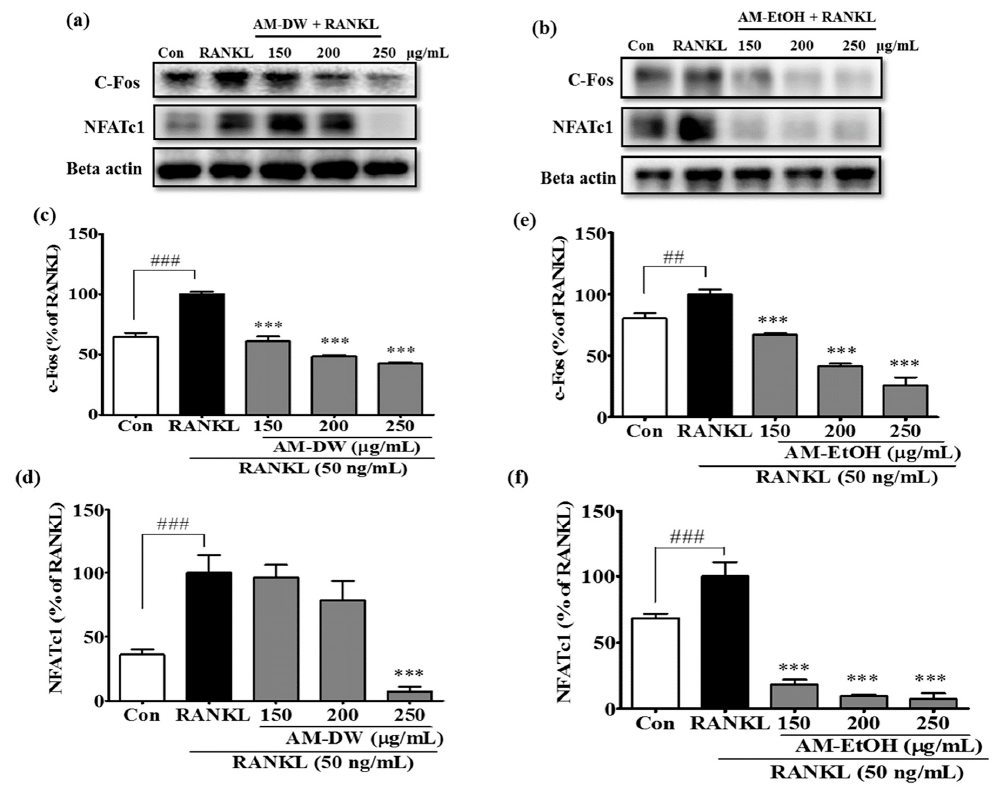
Figure 7. Inhibitory effects of AM extracts on c-Fos and NFATc1 expression in RAW 264.7 cells induced by RANKL. ( a , b ) AM extracts inhibited the expression of c-Fos and NFATc1; ( c – f ) Band intensities for c-Fos and NFATc1as percentages of the RANKL treated group (set as 100%), respectively for AM water and ethanol extracts. RANKL treated group was considered as 100% for densitometric analysis. Cells were exposed to RANKL (50 ng/mL) in the presence and absence of AM extracts for 3 days. The expression of the proteins were determined by Western blot analysis and Beta actin was used as loading control. All data are presented as the mean ± SD of three independent experiments performed with n = 3. *** p < 0.001 vs. RANKL treated group; and ## p < 0.01, ### p < 0.001 vs. Con group. Con; positive control, (which was not treated), RANKL; negative control, (which was treated with only RANKL).